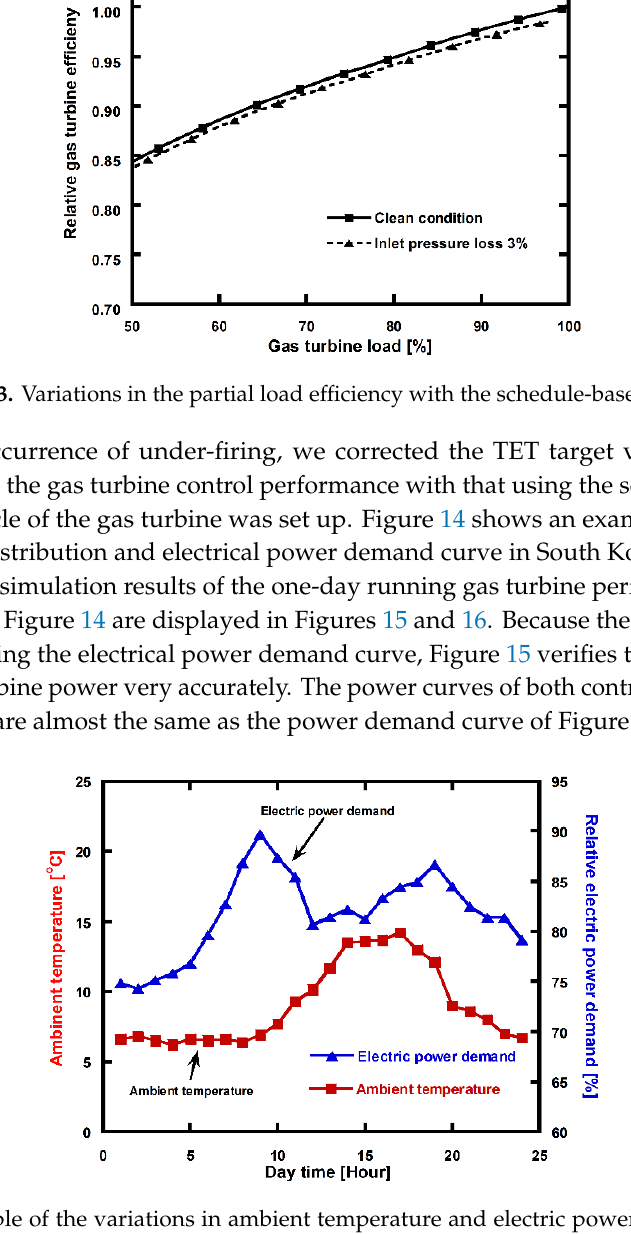
Figure 15. Variations in power production and efficiency of the gas turbine during a day. Figure 16. Simulated variations in TET and TIT of the gas turbine during a day.